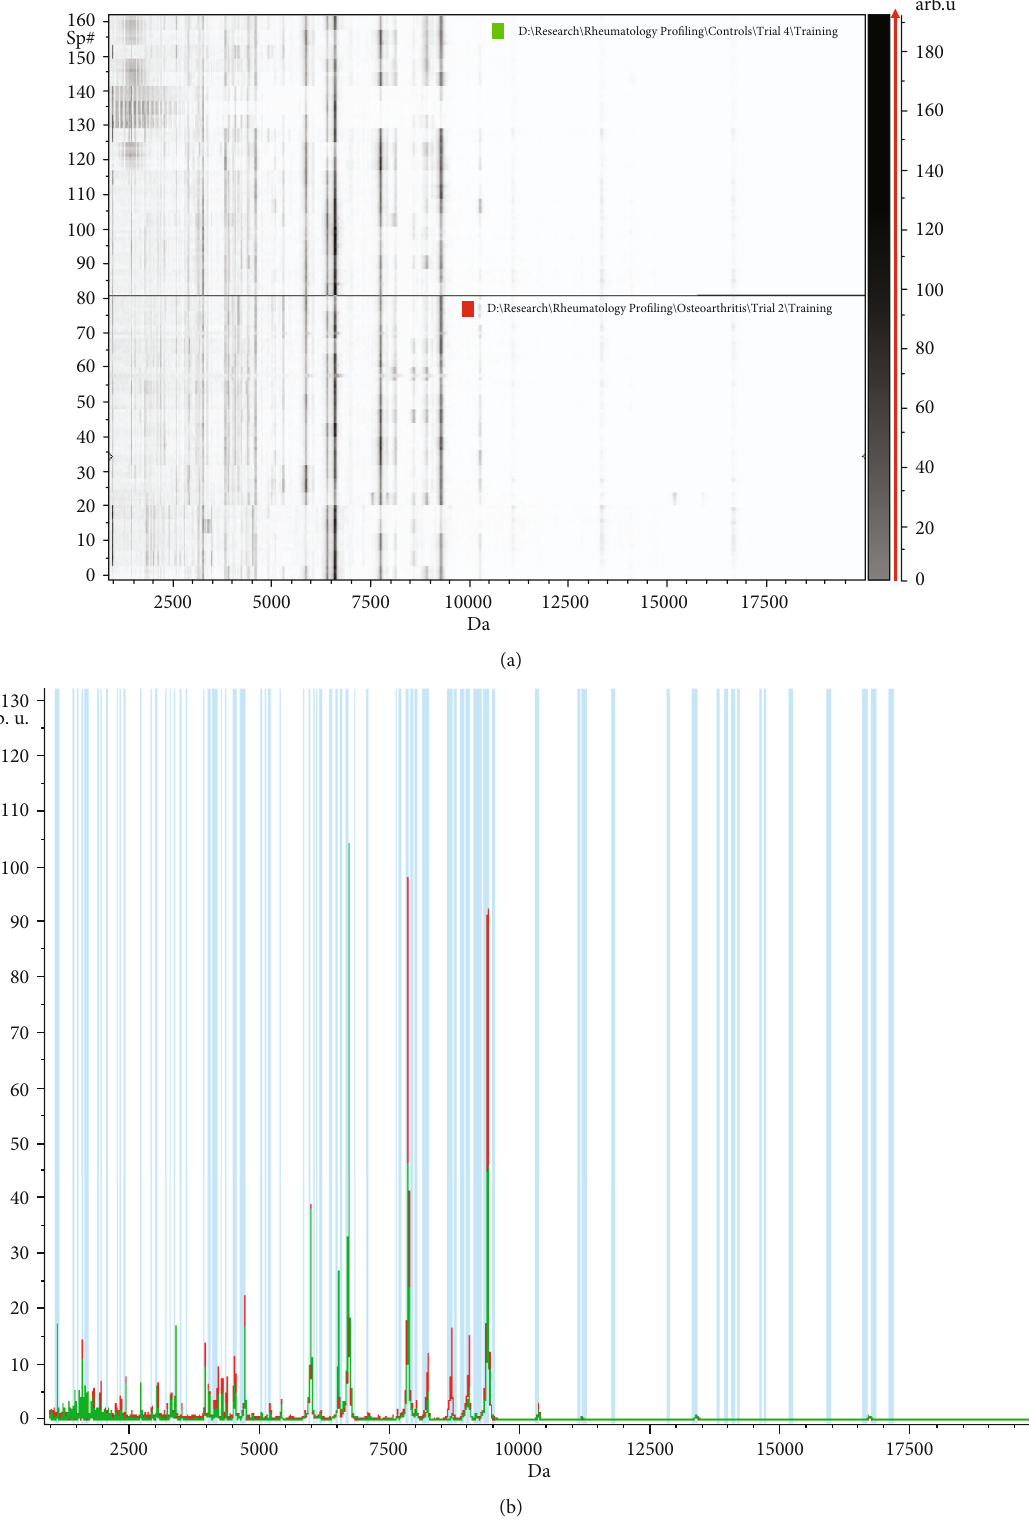
Figure 3: Peptidomic analysis of osteoarthritis (OA) versus healthy control (HC) group. (a) The pseudogel view using ClinPro Tools. The OA group at the bottom and HC at the top. Each peak is represented by a vertical line. The di ff erence in intensity between the lines represents the di ff erential peak expression between the two groups. (b) The whole spectral view in ClinPro Tools. The fi gure represents the OA group in red against HC in green. Peaks included are demarcated with vertical blue lines. Peaks demarcated with red vertical lines are the integration